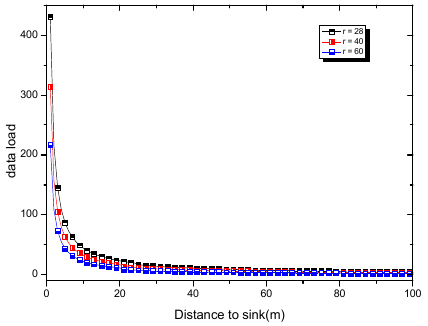
Figure 9 . The amount of data that the node assumes decreases as the distance from the sink node decreases.